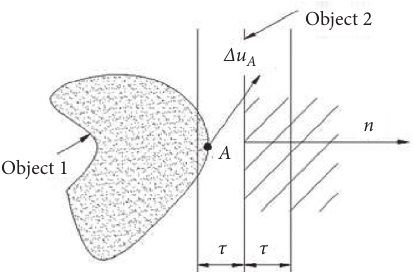
Figure 1: A sketch of nonpenetrating